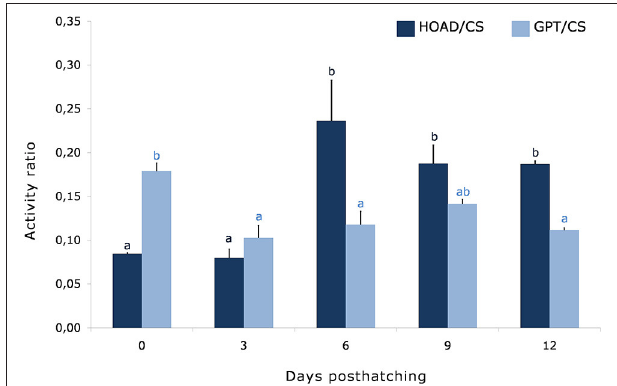
TABLE 4 | Activity of key enzymes of intermediary metabolism in Octopus vulgaris palarvae at hatching (0) and after 12 and 28 days of feeding with control diet (C, Artemia enriched with phytoplankton) or LC60 diet ( Artemia enriched with Marine